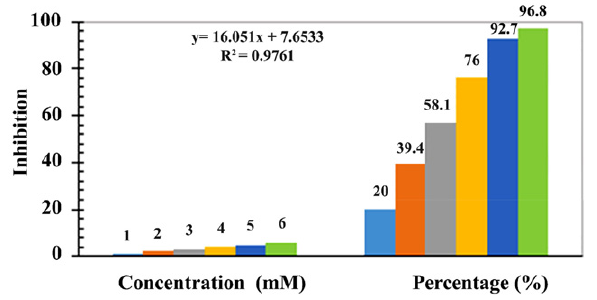
Fig. 5 . Graphical representation of Antioxidant Activities of the Standard ( Ascorbic Acid )